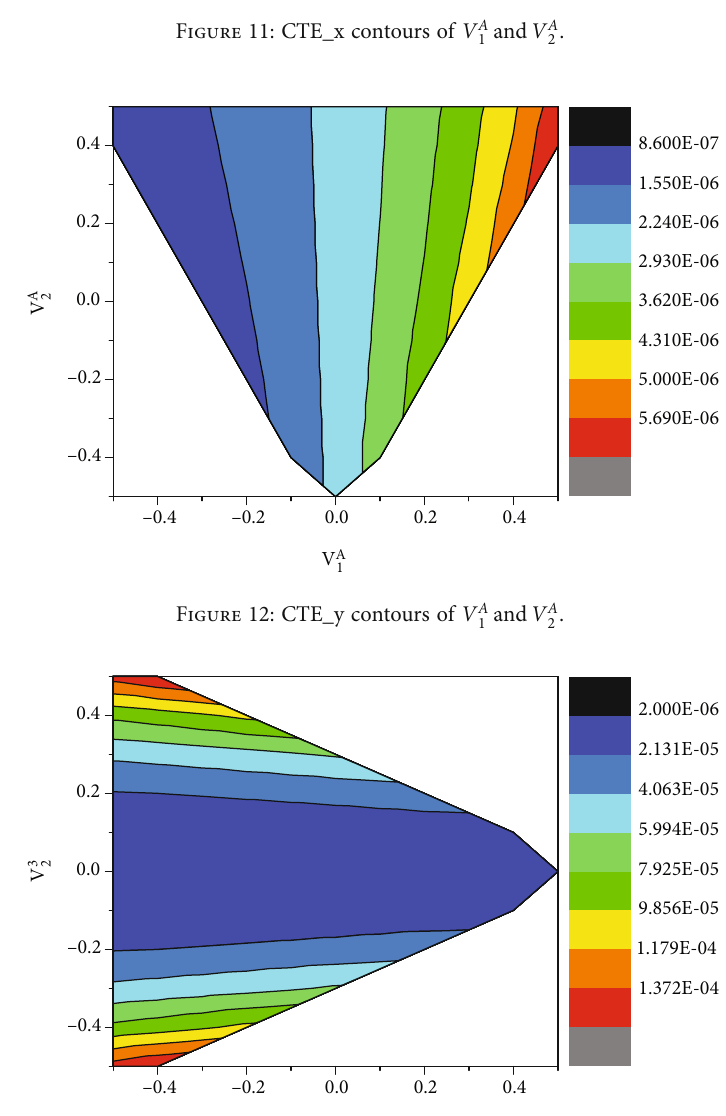
Figure 11: CTE_x contours of V A